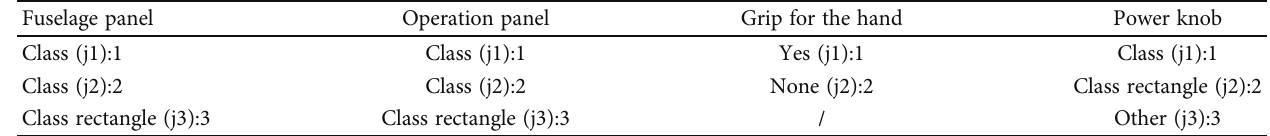
Table 3: Modeling elements of sweeping